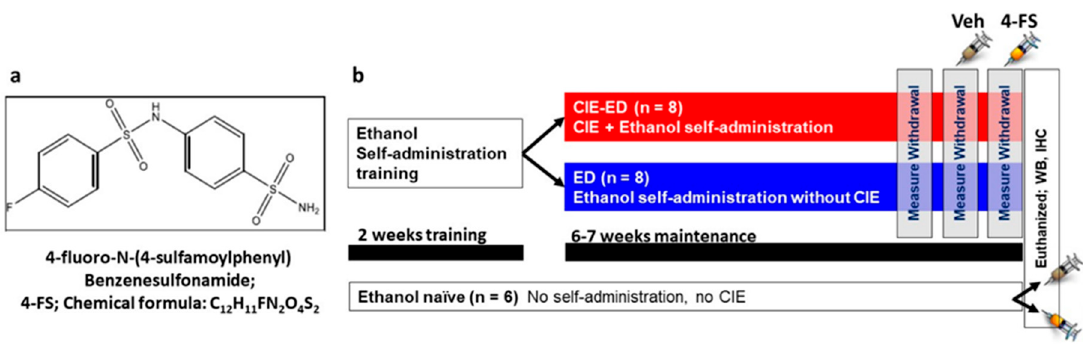
Figure 1. ( a ) Chemical structure of 4 ‐ FS. ( b ) Schematic of the experimental timeline and experimental group information.